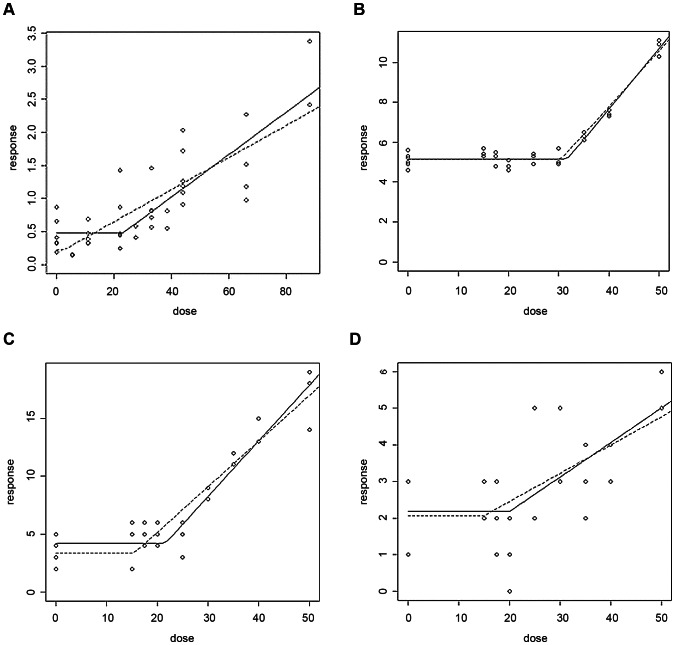
Mammalian cells treated with bisphenol-a (BPA) using the following endpoints.(a) MN (AHH-1), (b) MI (V79) and (c) Tripolar (V79), and (d) multi+tetrapolar (V79). Graphs shown are from the Lutz and Lutz (2009, [23]) hockey stick model for R, with the dotted line being the lower 95% confidence interval. The x-axis ‘dose’ is in µM, and y-axis ‘response’ is % cells.